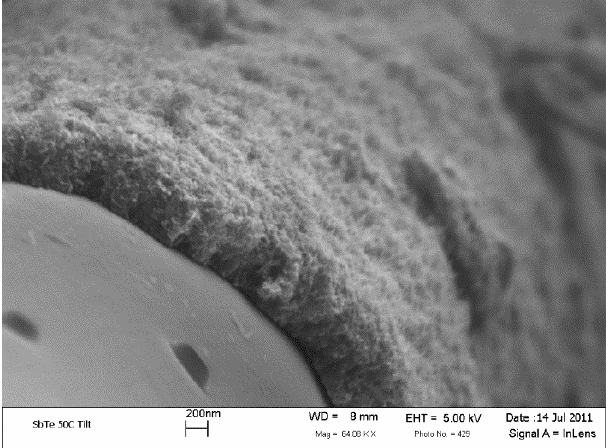
Figure 5. Cross-sectional SEM micrograph of a carbon fiber grafted with surface-grown carbon nanofilament utilizing the GSD technique.